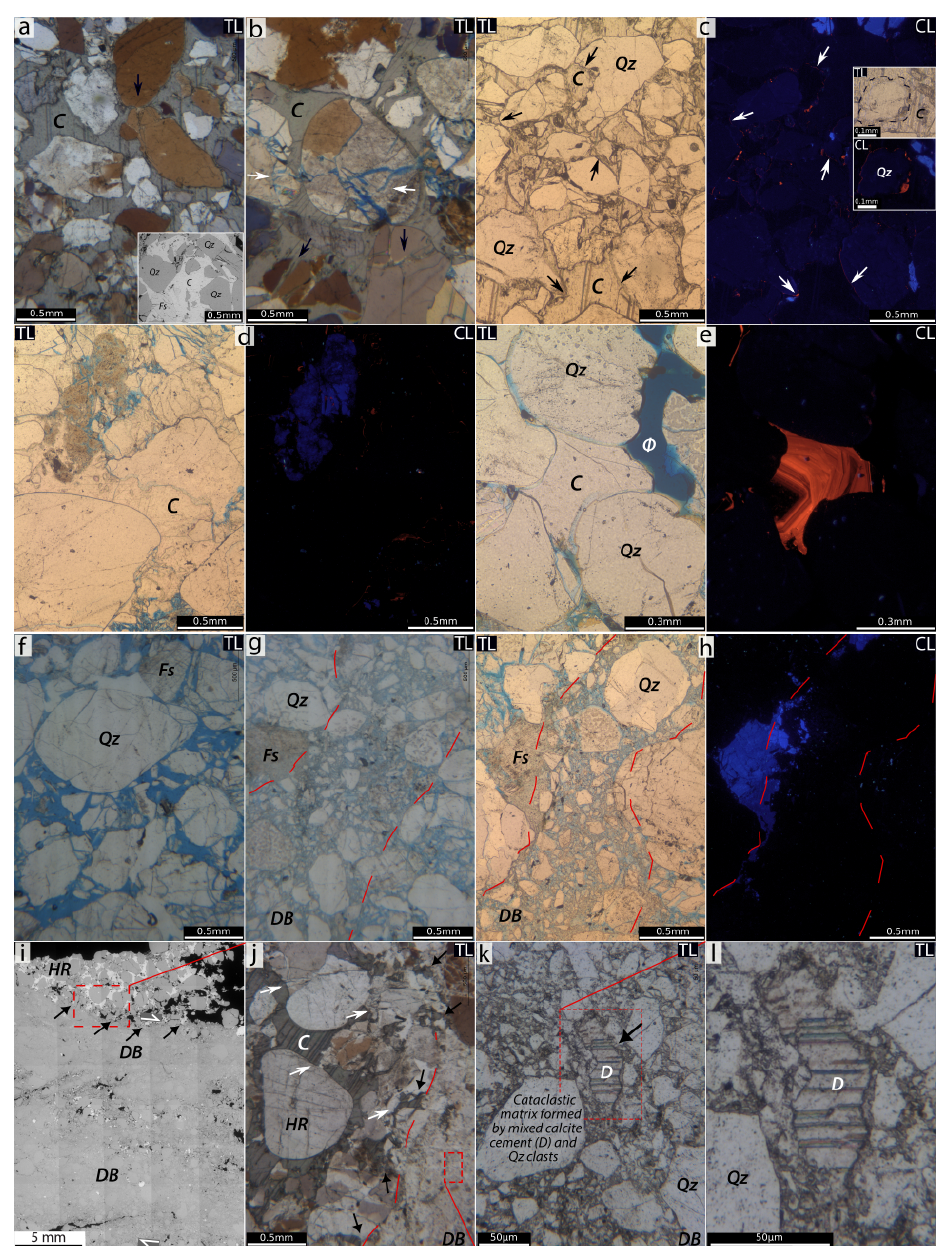
Figure 11. Natural- and CL-light photomicrographs showing the internal texture and microstructure of (a–e) spherical and tabular nodules and (f–l) DBs. (a, b, f) Host rock grains are mostly rounded and nearly undisturbed. Some microfractures break framework grains at contact points. In nodules, (a) some of the microfractures are filled; (b) a few are not. (g, h) Microfractures are more frequent approaching the DB, and (j) they are preferentially oriented with respect to the band (white arrows). Cement fills intergranular pore space and intragranular fractures. (c–e) The major diagenetic component is poikilotopic spar cement with dominant dark luminescence and (e) minor bright-orange CL growth subzones. (c) A very thin film of bright-orange CL calcite cement often coats detrital grains. Minor diagenetic alterations are corroded detrital grains that are partially replaced by calcite cement; see inset in (c) . (g, h) NW–SE bands and (i, l) NE–SW strike-slip bands show a similar pattern, but NE–SW bands feature a high degree of grain comminution and porosity reduction. (i, j) NE–SW strike-slip bands crosscut cement nodules; intragranular fractures (white arrows) and incipient stage of cement comminution (black arrows) between quartz clasts in the host rock sectors in proximity to these bands. (k, l) Fine particles of crushed detrital calcite cement (D) are found among the matrix grains at the crosscutting site. The inset in (a) is a backscattered electron SEM image. Qz – quartz; Fs – feldspar; φ – pore space; C – calcite cement; TL – transmitted light. See Supplement S1 for